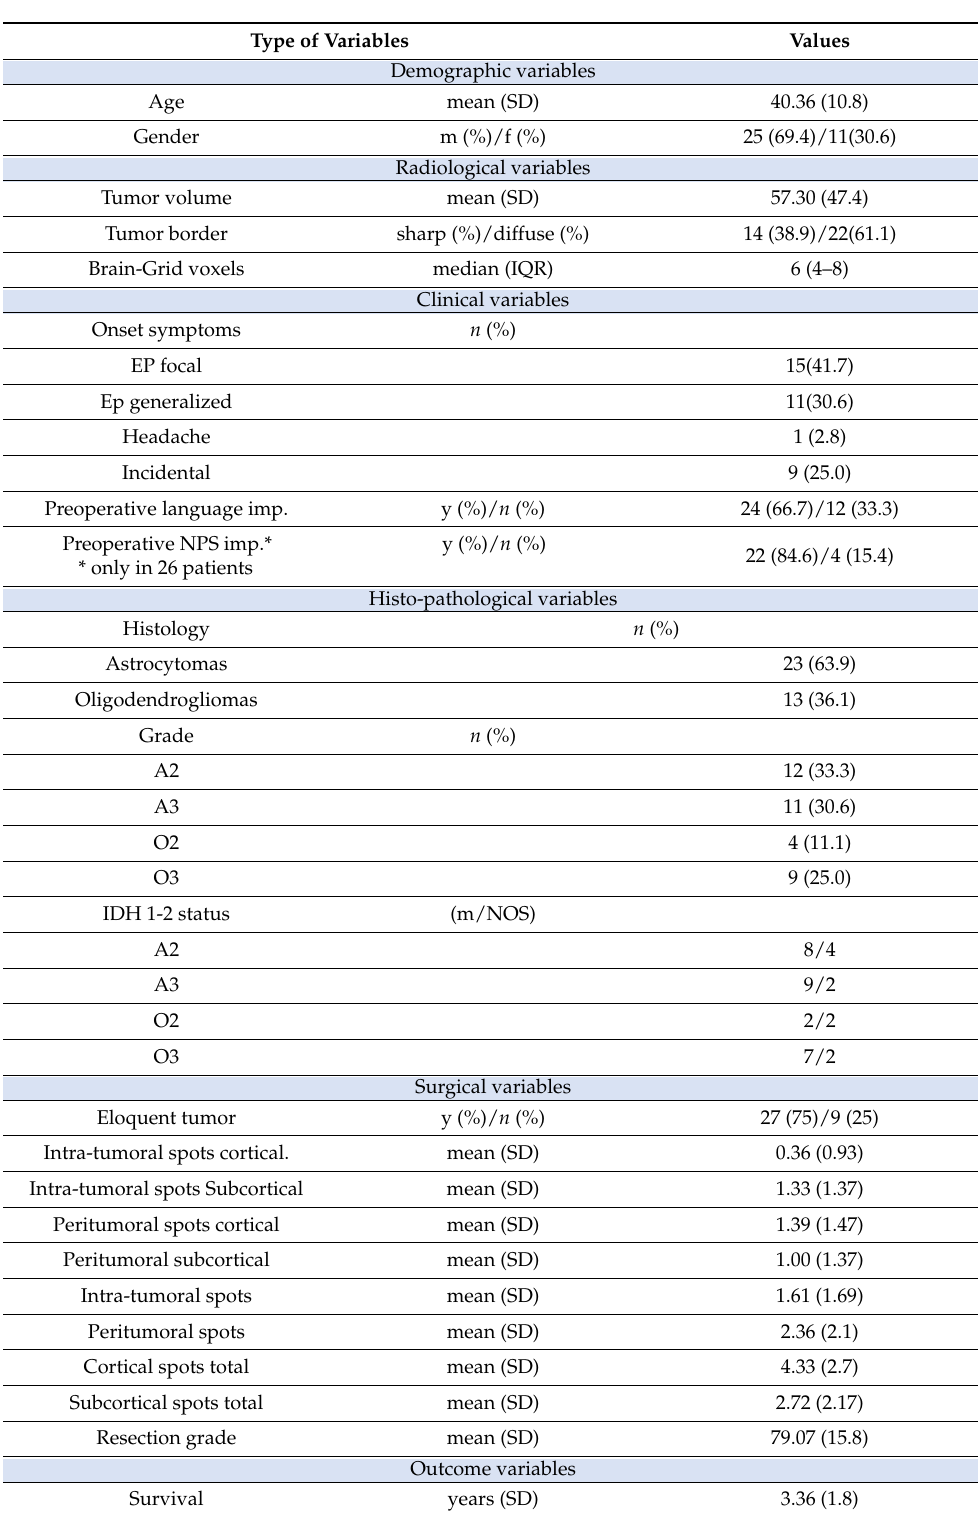
Table 1. Summary of the descriptive results of demographic, radiological, histological, intraoperative and outcome